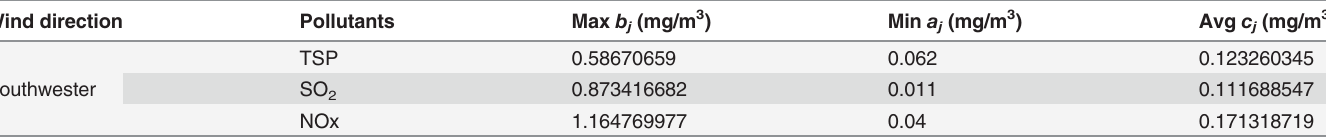
Table 1. The components of matter element matrices. Wind direction